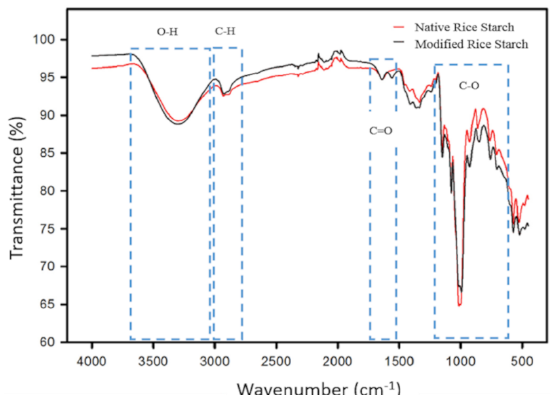
Figure 1. FTIR spectra of native rice starch and extrusion modified rice